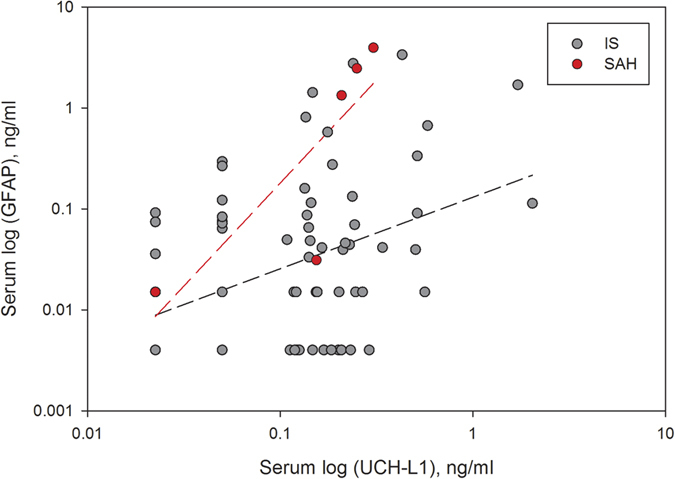
Correlations of logged serum GFAP and UCH-L1 concentrations in patients with IS and SAH (r = 0.36 and r = 1.00, respectively, test based on the Spearman’s rank correlation).